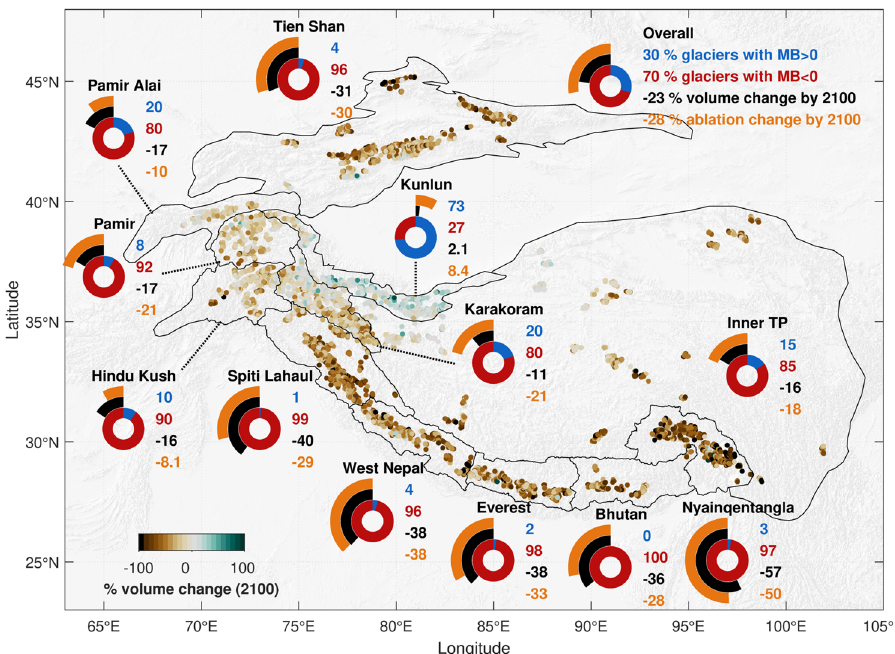
Fig. 4 Changes in glacier volume and total ablation by 2100 implied by 2000-2016 mass balance regime, based on a glacier retreat and advance fl ow parameterization. Regional icons depict the portion of glaciers with positive (blue) or negative (red) glacier-wide mass balance, implied volume change by 2100 as portion of glacier volume (black), and implied change in total annual glacier ablation by 2100 as a portion of current total annual ablation (orange). Background is a hillshade of the GTOPO30 dataset sourced from the USGS